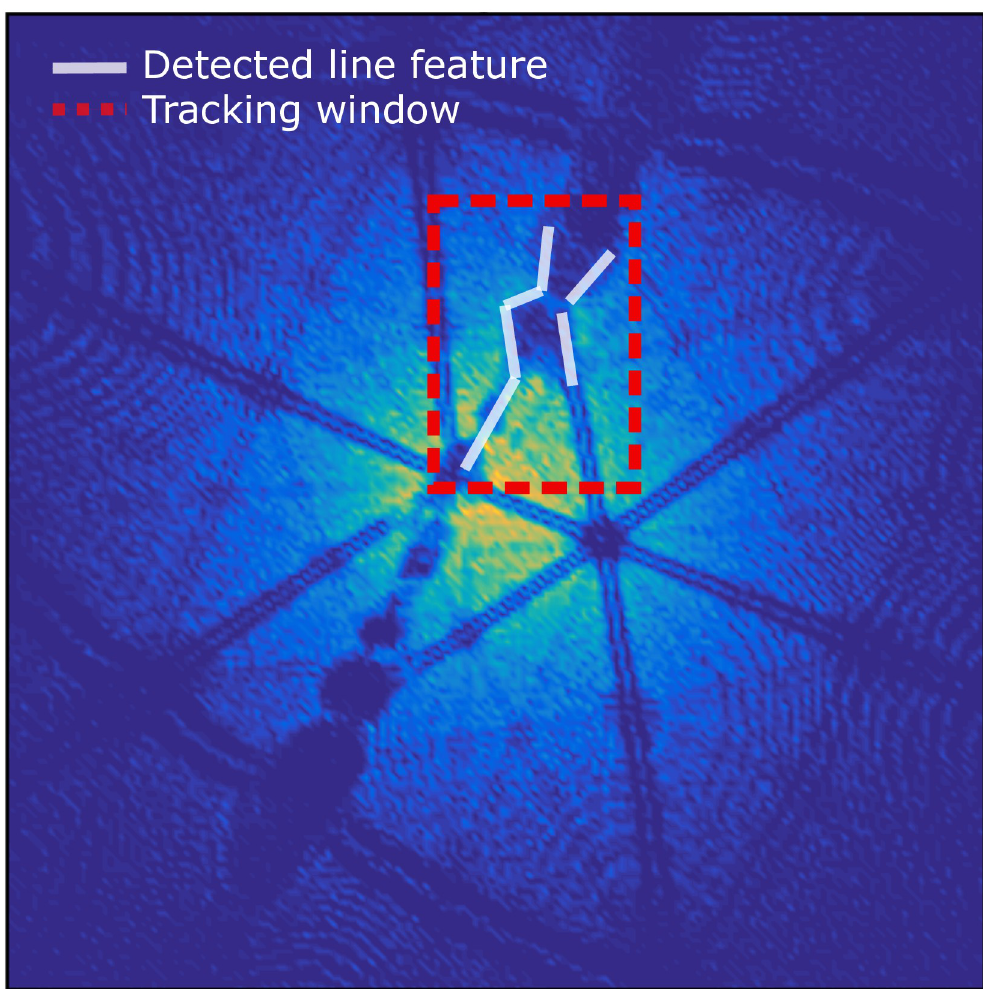
Fig 10. TAPSim-based detector hit map: The lines detected (shown in white) are quasi-linear local ion density fluctuations which the Hough transform picks up. These are affected by the geometry, e.g. the thickness of the boundary, the atomic structure of the adjoining crystals, and known TAPSim field evaporation artifacts